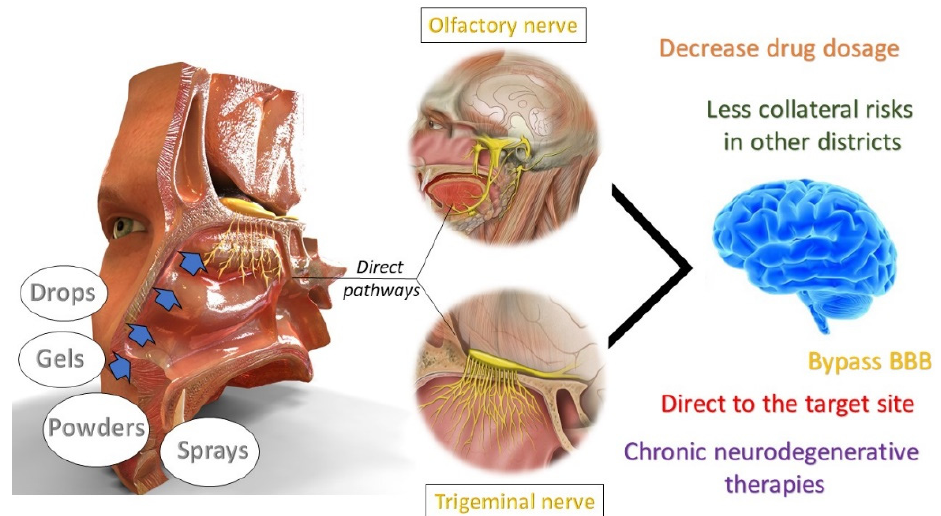
Figure 2. Strategies of direct drug delivery to the brain by intranasal administration: common pharmaceutical forms, pathways involved, and the challenges of nose-to-brain delivery.